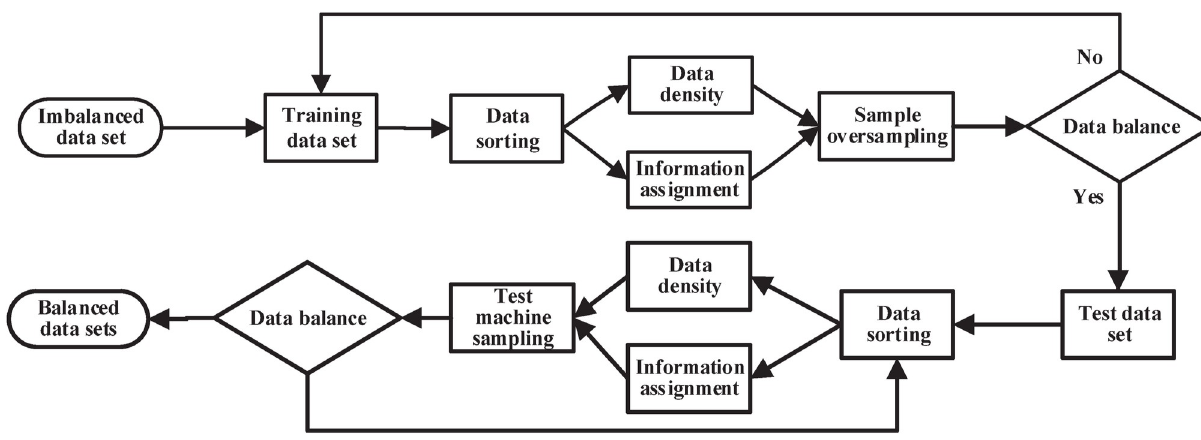
Fig 3. The classification oversampling algorithm flow